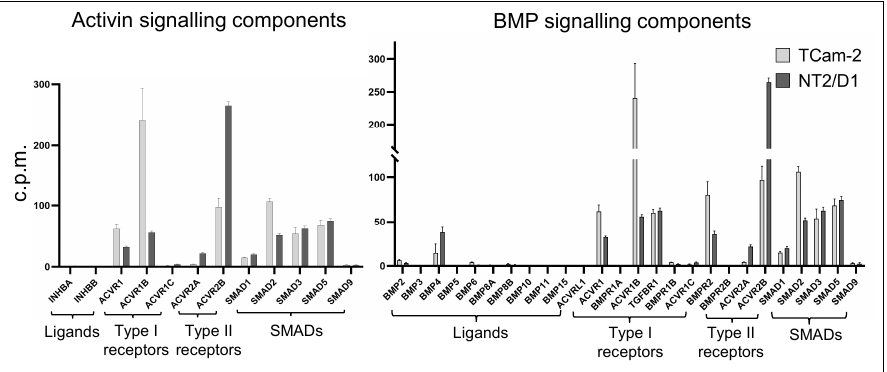
Figure 1. TGF- β superfamily signalling pathway transcript levels. Transcript levels encoding activin and BMP signaling components identified in [54] differ between the two testicular cancer cell lines. Data are the mean of counts per million (cpm) in control cells (cultured in vehicle only) from four independent RNA-seq experiments (n = 4); error bars indicate standard error of the mean (SEM). A gene was considered as differentially expressed if transcript levels were